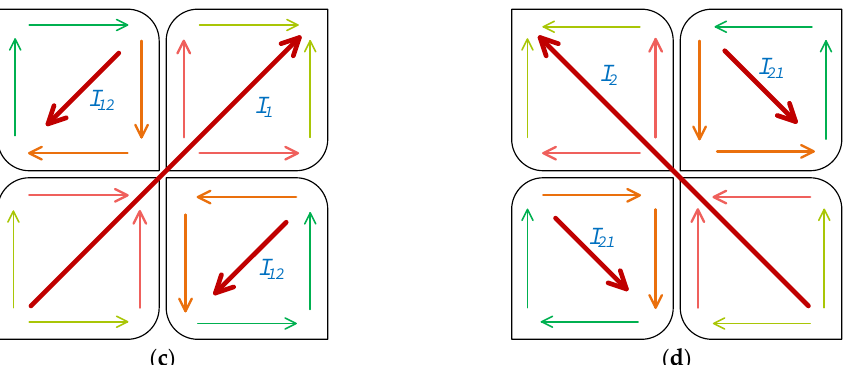
Figure 3. Current distribution excited by ( a ) port 1 and ( b ) port 2, and the equivalent current on the radiators corresponding to the excitations of ( c ) port 1 and ( d ) port 2 at a phase of π /4.